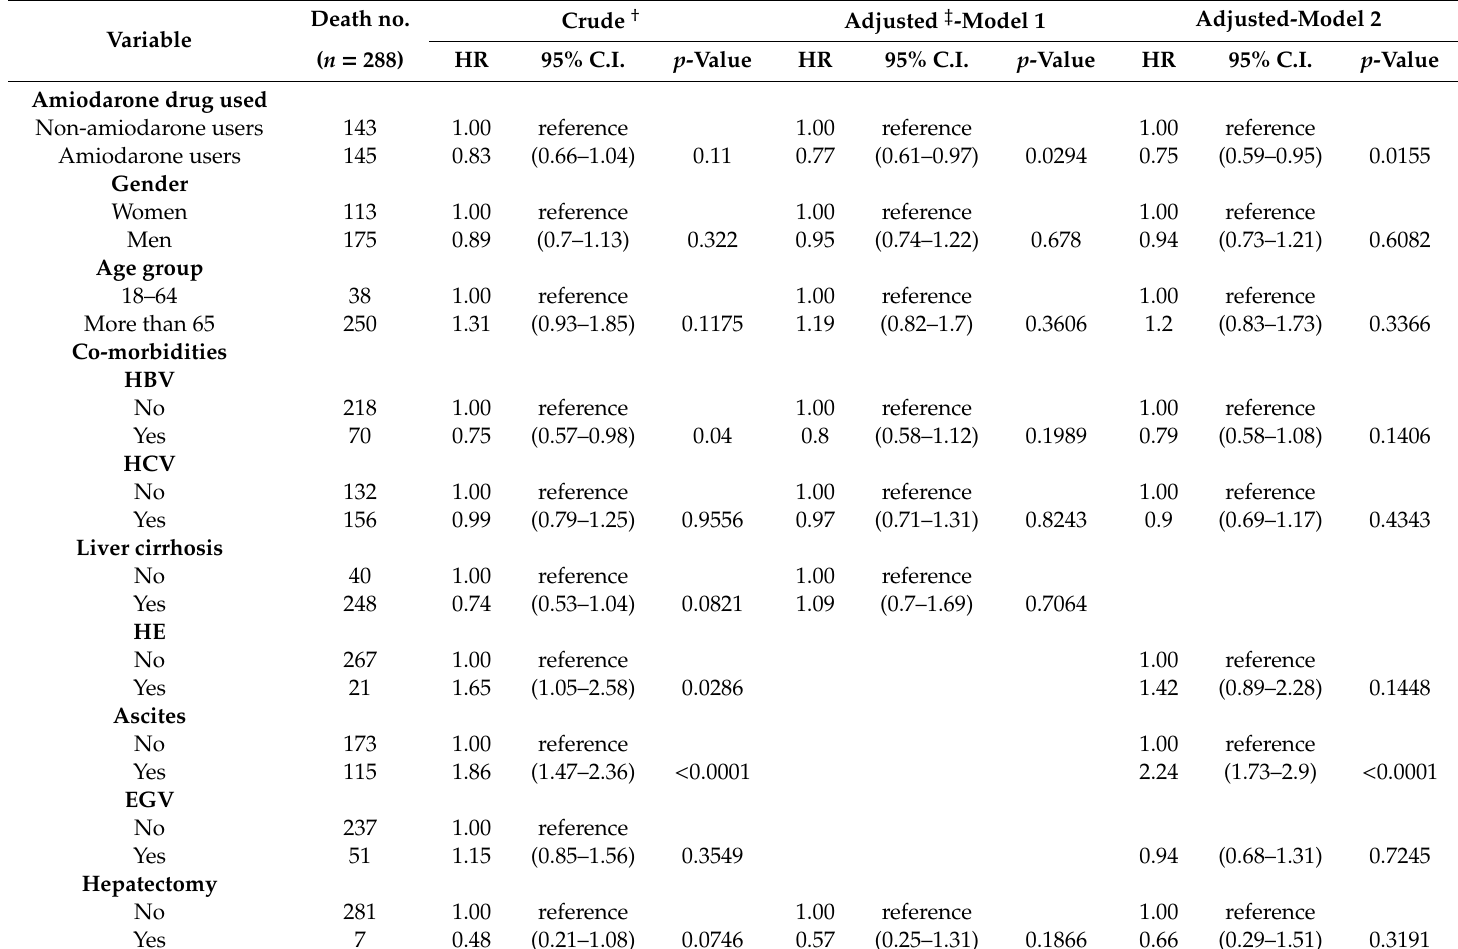
Table 2. Cox model with hazard ratios and 95% confidence intervals of mortality associated with amiodarone and covariates among patients with